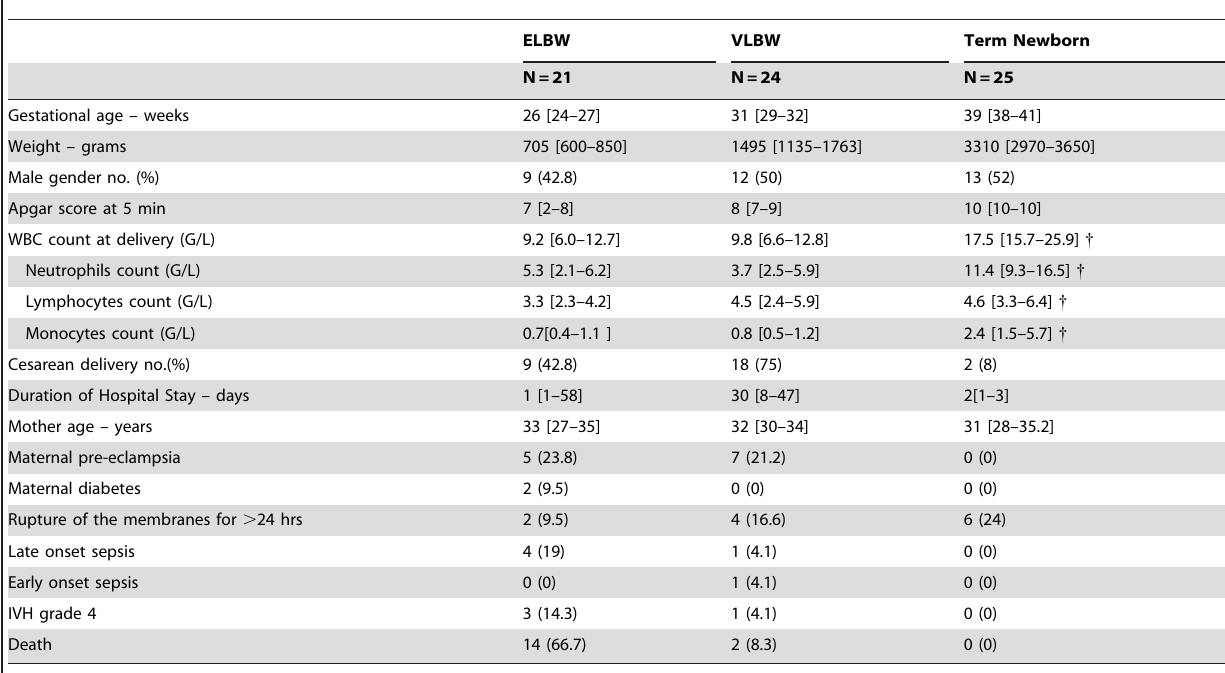
Table 1. Baseline Characteristics and outcome of